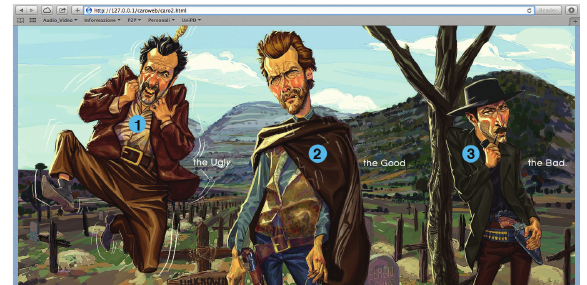
Figure9:Thecontrolspaceisusedtochangeinteractivelythesound comment of the multimedia product (a cartoon from the movie “The Good, The Bad and The Ugly” by Sergio Leone, in this